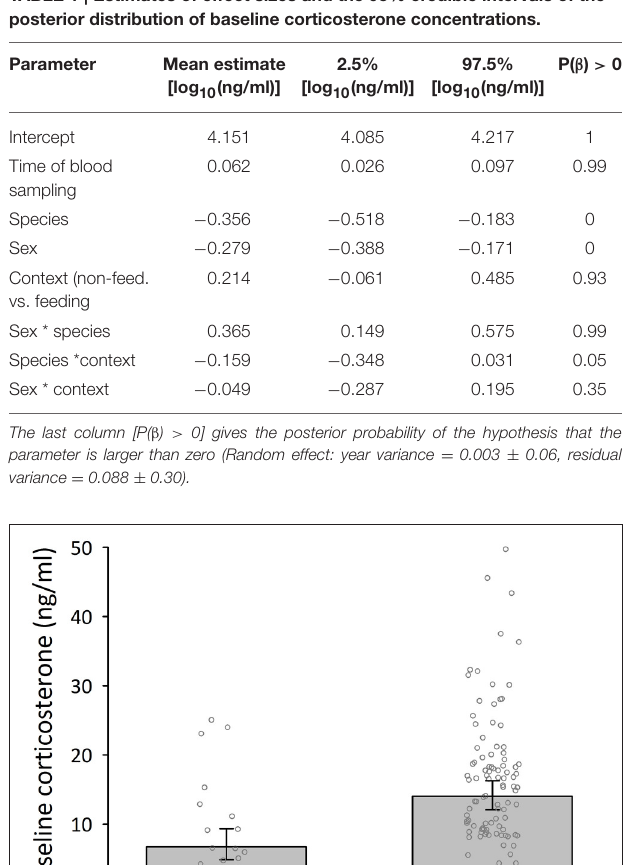
( Figure 2 ) with those of non-parenting male black coucals and male and female white-browed coucals ( Figure 1A ) shows that during the pre-breeding season, when female black coucals have not yet started to intensely compete for territories and did not yet produce clutches, their baseline corticosterone concentrations are similar to those of male black coucals that do not feed nestlings, and female and male white-browed coucals, regardless of their